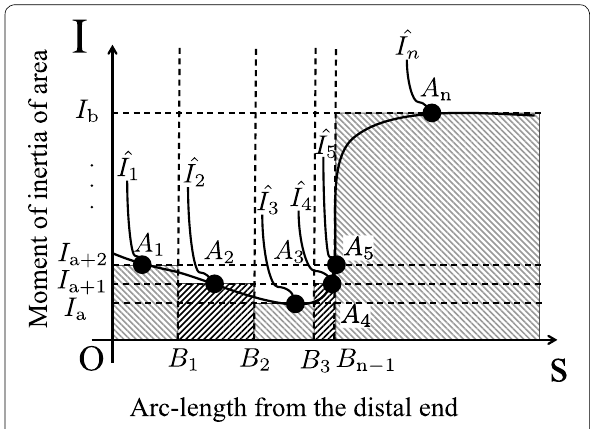
Fig. 7 Sampling of I ( s ) with respect to